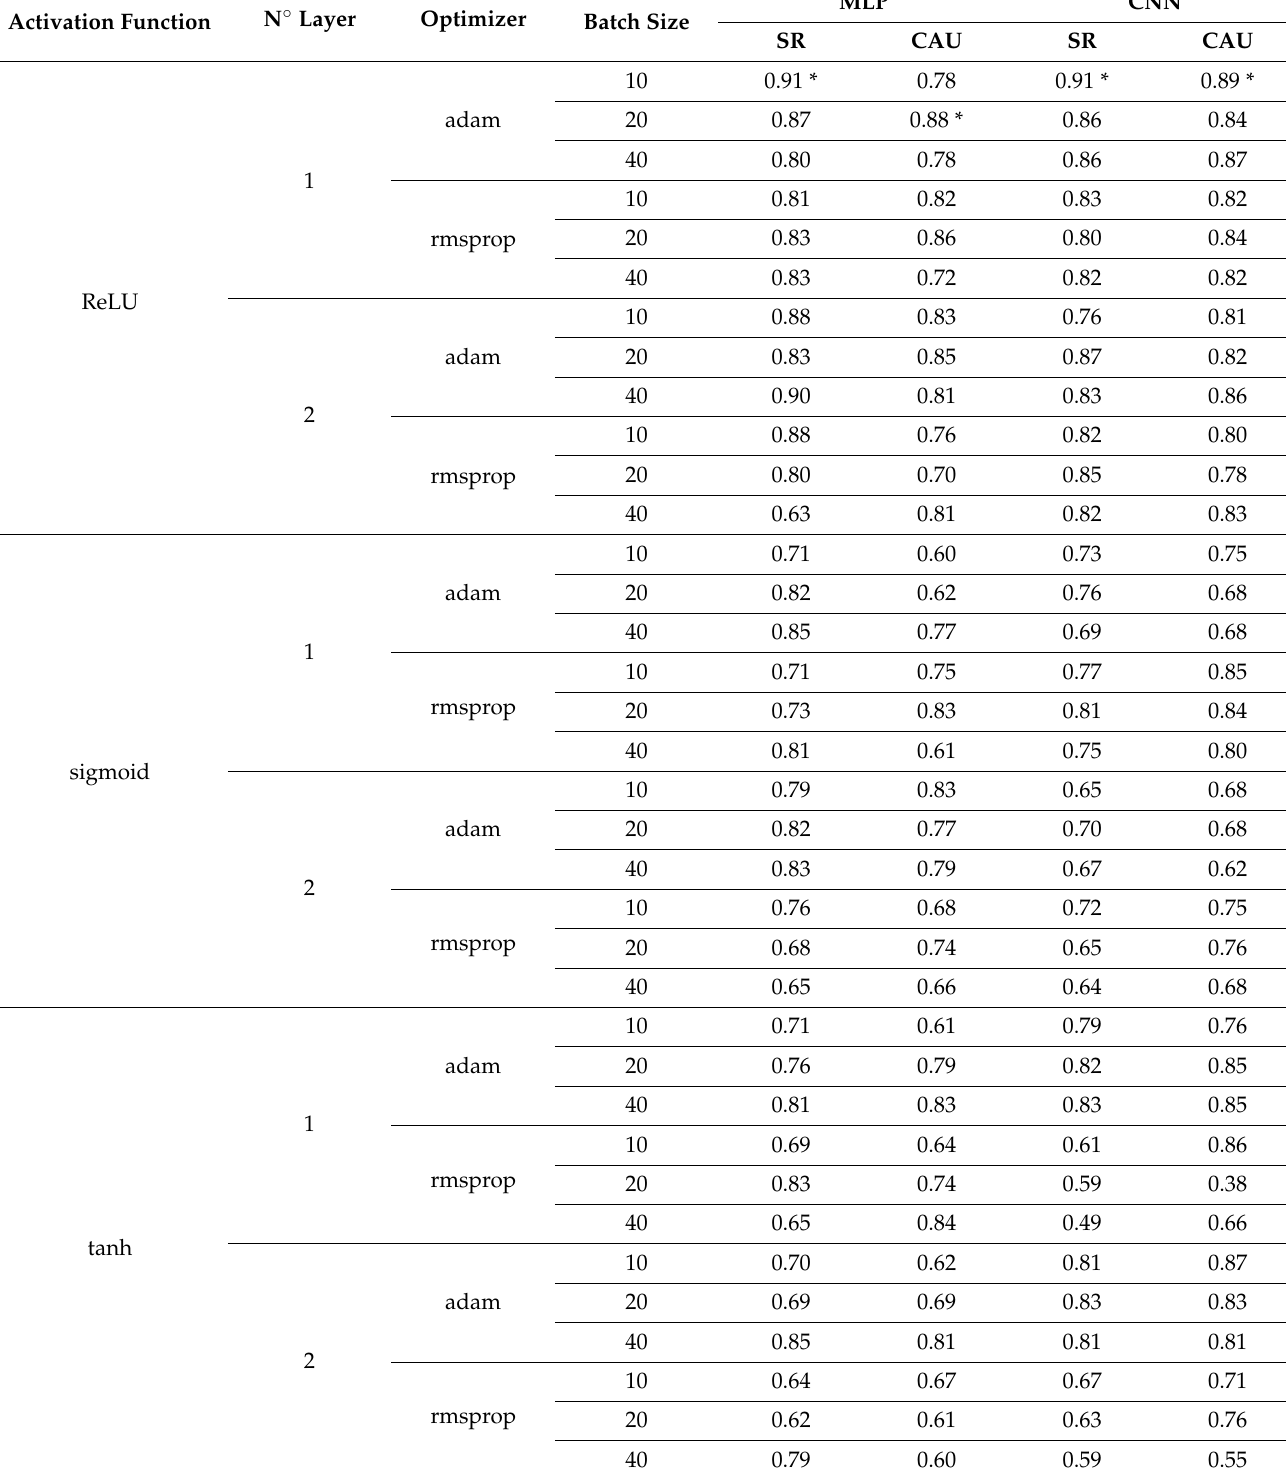
Table 1. Classification accuracy of the population structure in wheat for 36 MLP and CNN models, considering different hyperparameters: activation function (ReLU, Tanh, and Sigmoid), N ◦ layer (one or two dense layers in MLP—one or two extra dense layers in CNN), optimizer (adam or rmsprop), and batch size (10, 20, and